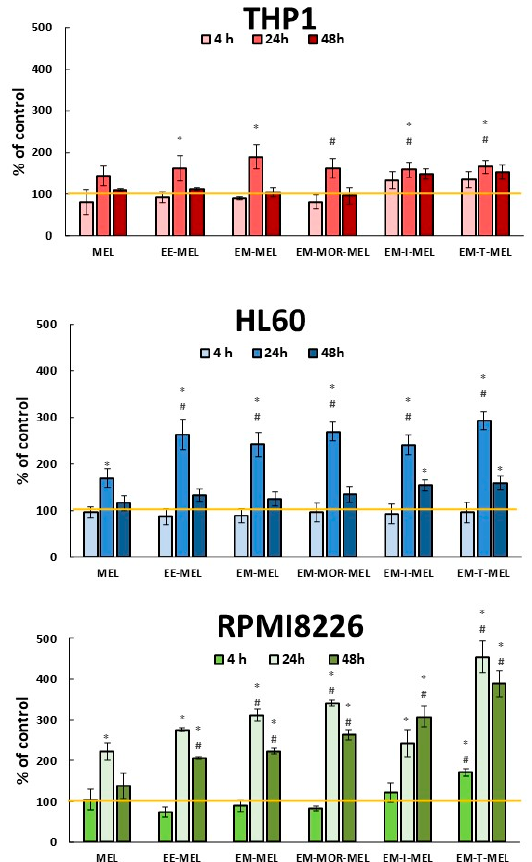
Figure 5. Melphalan derivatives-induced caspase 2 activation. HL60, THP1, RPMI8226 cells were incubated for 4, 24, and 48 h with MEL, EE-MEL, EM-MEL, EM-MOR-MEL, EM-I-MEL, and EM-T-MEL. The final results are expressed as the percentage of activity of a specific cysteine protease, with the untreated control taken as 100%. All data are from three biological assays, and are graphed as the mean ± SD. (*) Statistically significant differences compared to the control cells, p < 0.05. (#) Statistically significant differences compared to MEL at the same time point, p < 0.05.